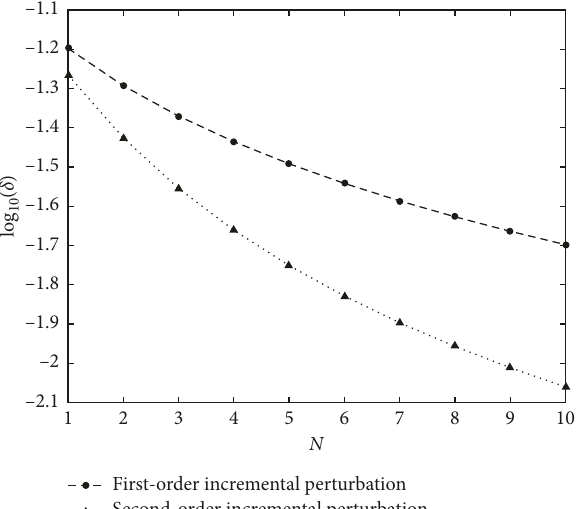
Figure 4: The error parameter, δ , for the perturbed modal matrices of the torque-free rigid body as a function of N for σ � 1 . 8.